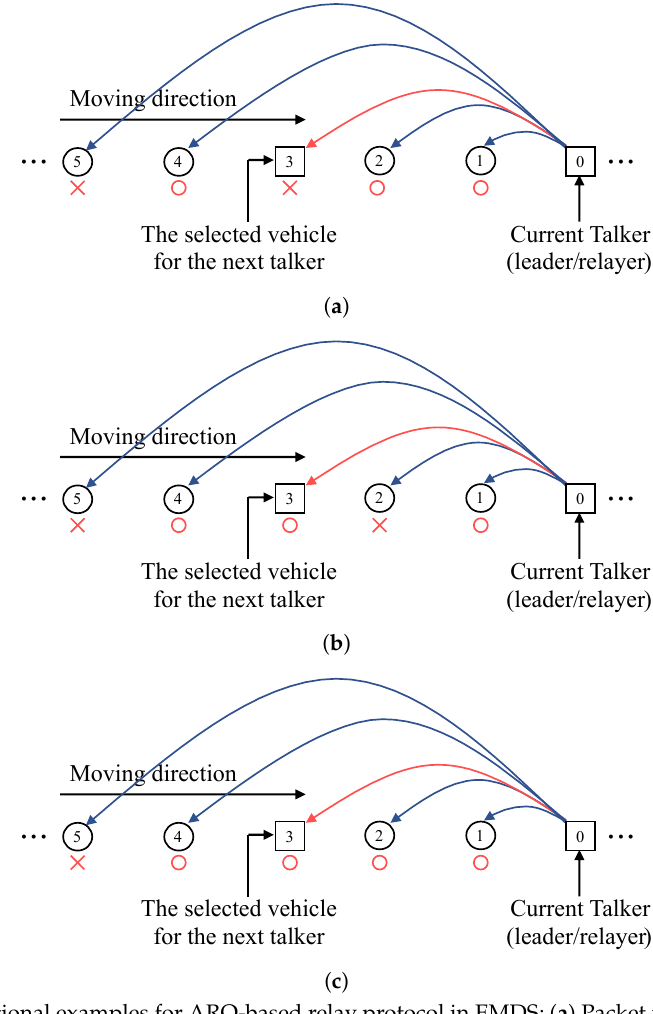
Figure 3. Operational examples for ARQ-based relay protocol in EMDS; ( a ) Packet reception failure at the selected vehicle as a next talker (Case 1), ( b ) Packet reception failure occurs at the vehicles located between the talker and the selected vehicle (Case 2), and ( c ) Success of next talker designation (Case